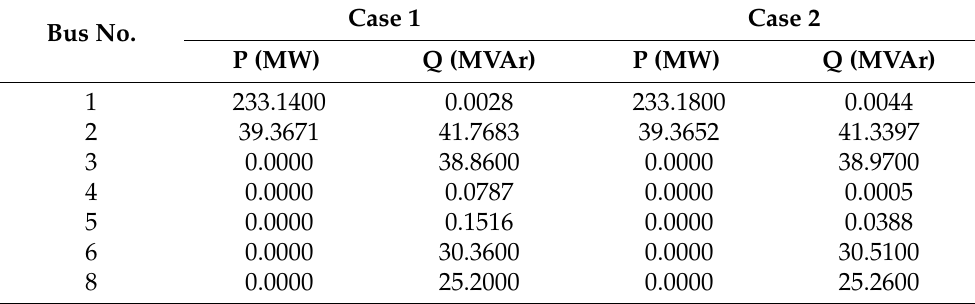
Table 12. Active and reactive generation result.